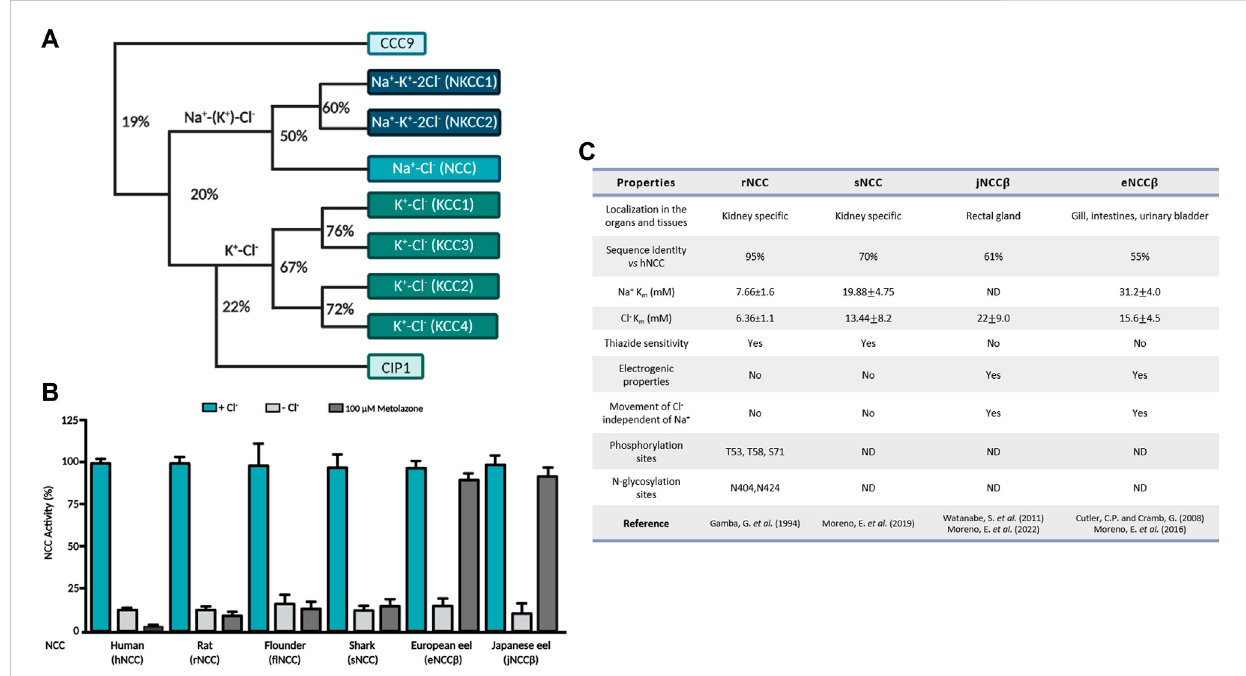
FIGURE 1 (A) Phylogenetic tree of the electroneutral cation-coupled chloride cotransporters of the SLC12 family. Numbers indicate identity percentage. (B) Functional expression of different NCCs in Xenopus laevis oocytes. NCC activity of different species measured in the absence of extracellular Cl − is represented by the light gray columns, meanwhile in the presence of the thiazide diuretic it is represented by the dark gray columns. (C) Summary of the different functional and structural properties of mammalian NCCs vs. NCCs from aquatic species. ND, not de fi